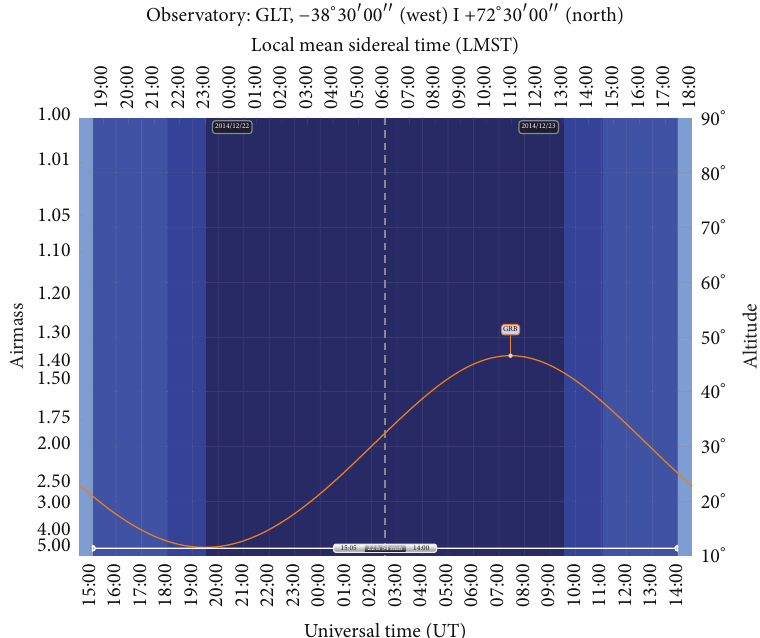
Figure 5: An example of visibility plot in winter for the GRB that declination is 29 deg. Hatchs indicate the sun altitude lower than −18 (dark blue), −12 (blue), −6 (dark cyan), and 0 (cyan) deg.,